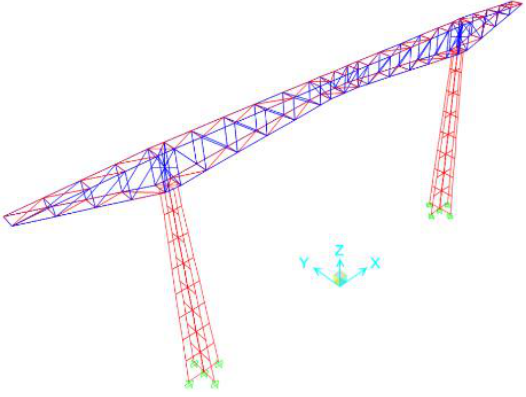
Figure 3. Finite element model of the eighth steel roof truss.